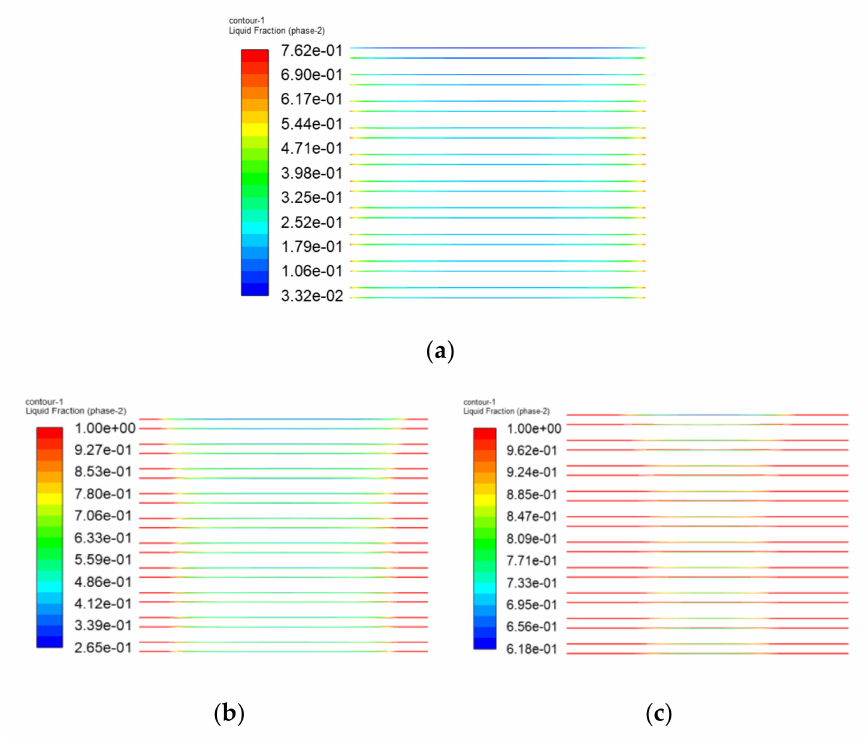
Figure 19. Liquid fraction contours of ice at di ff erent times; ( a ) t = 24 s, ( b ) t = 32 s, ( c ) t = 36 s.